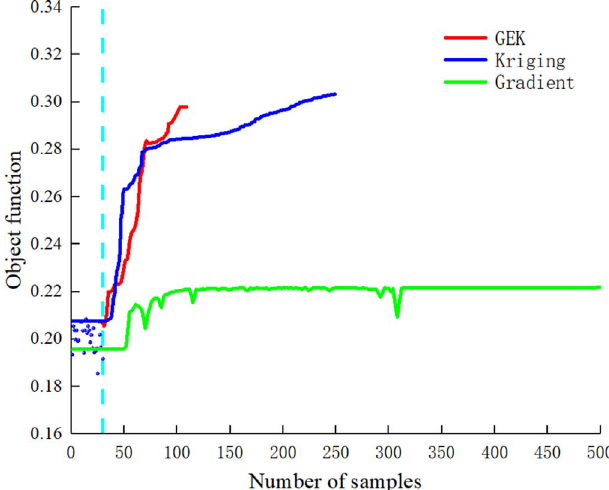
Figure 10. Sound absorption coef fi cients of different optimiza- tion models at low